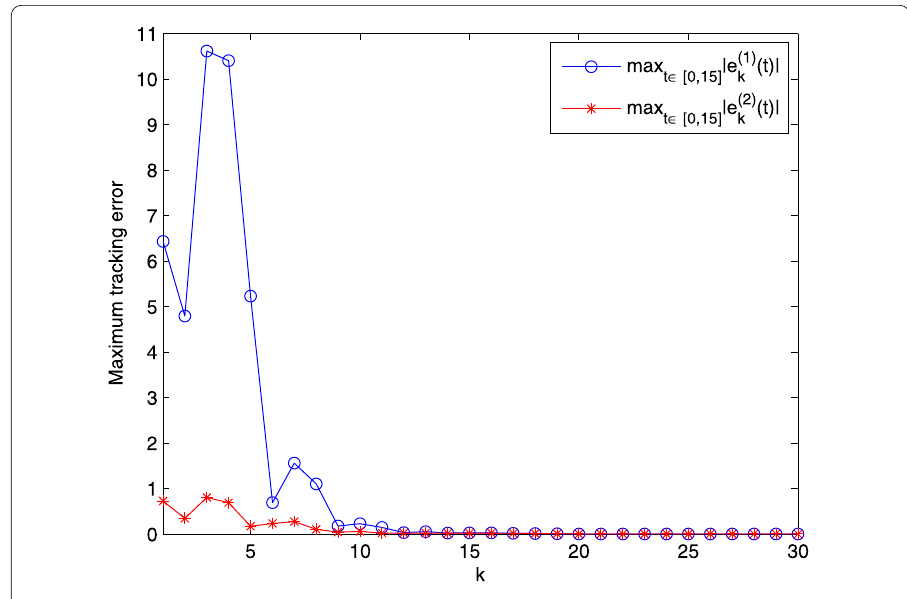
Figure 3 The maximum tracking error versus iteration